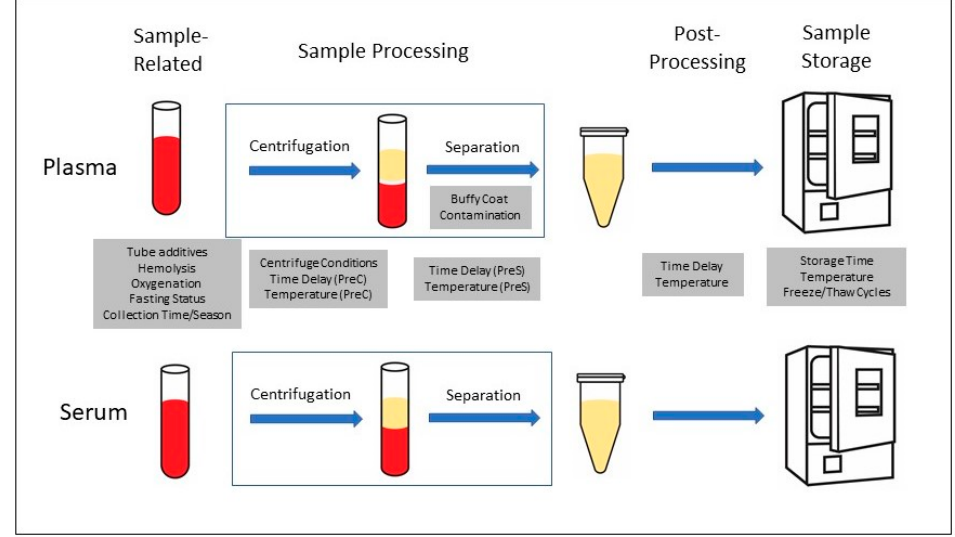
Figure 2. Pre-analytical variables for plasma and serum samples.